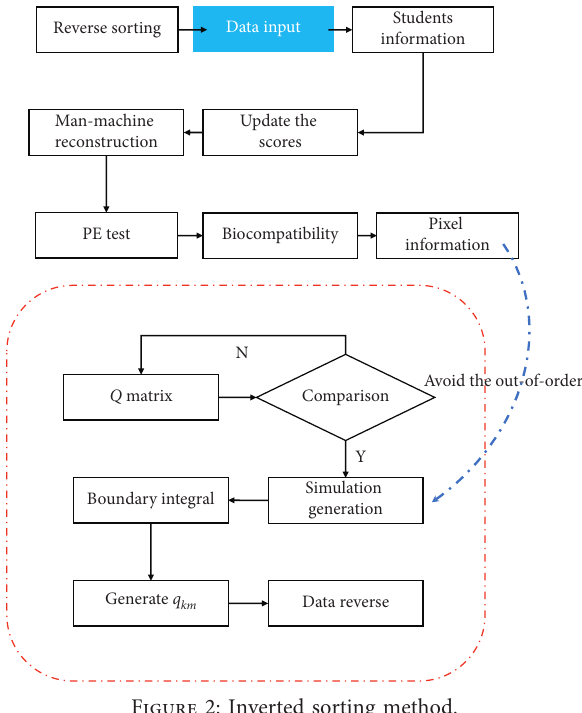
Figure 2: Inverted sorting